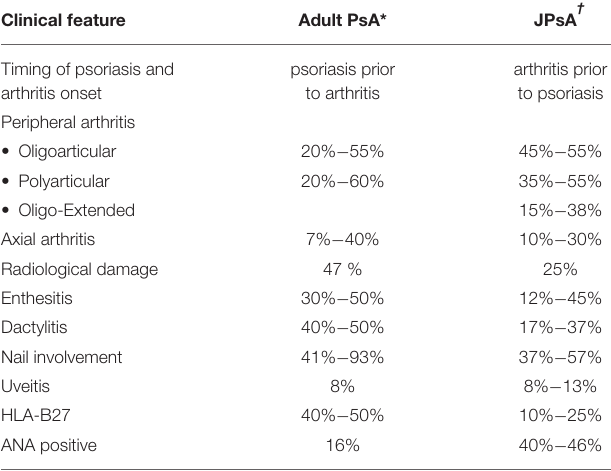
TABLE 1 | Differences between adult and pediatric-onset psoriatic